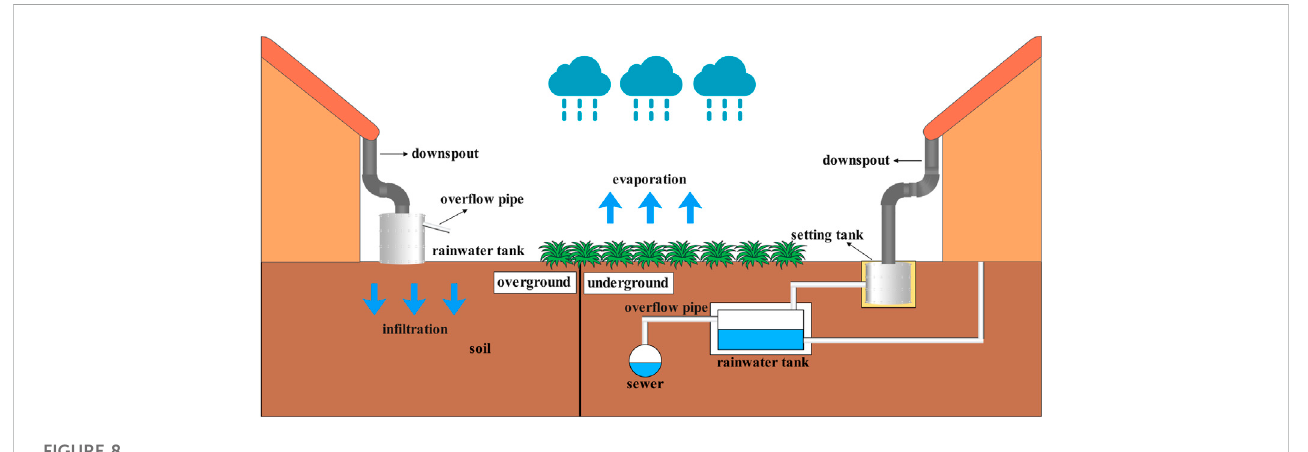
FIGURE 8 Speci fi c structure of the rainwater